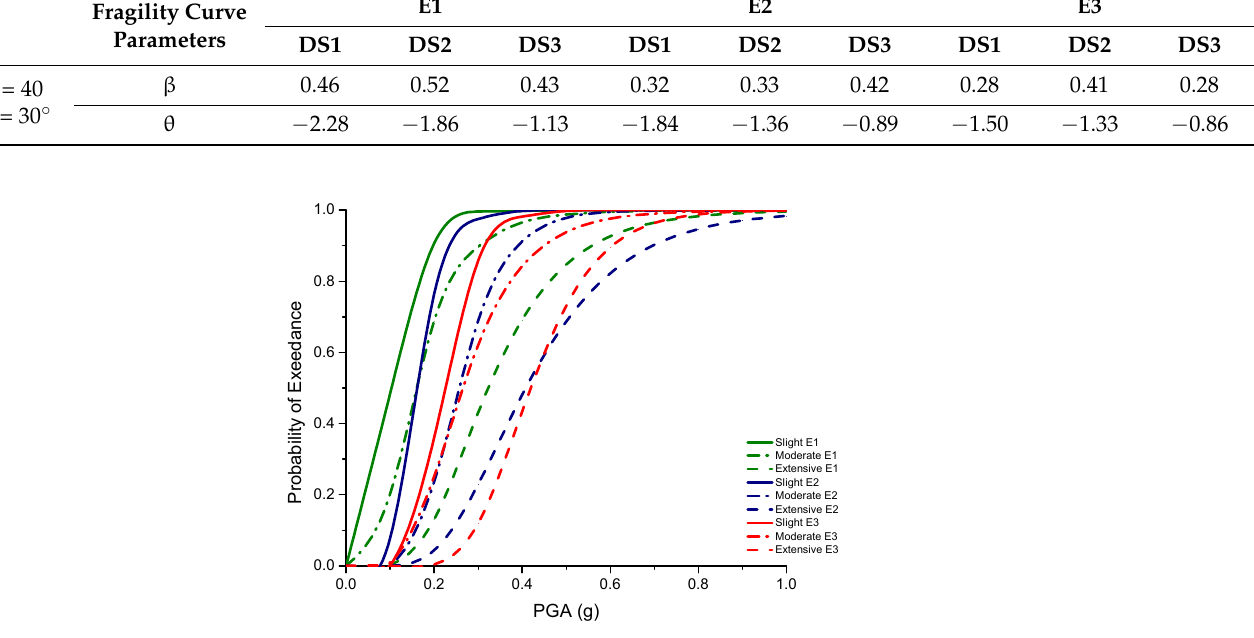
Figure 4. Fragility curves of the embankments due to all records with ϕ = 30° and c = 40 kPa.